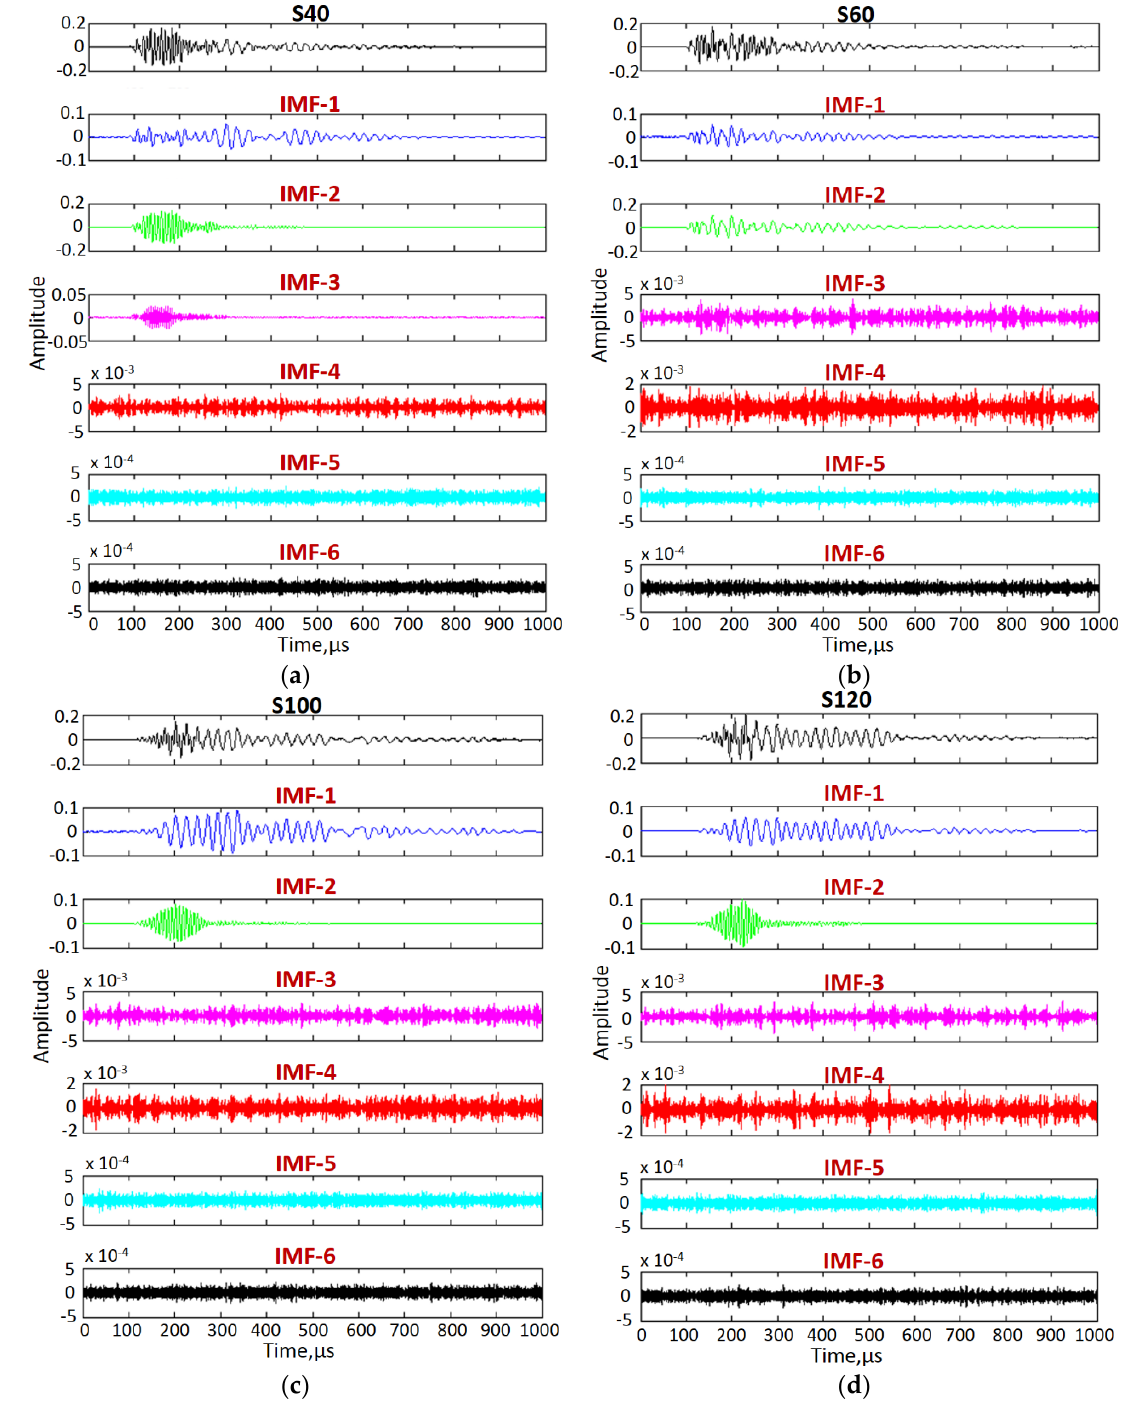
Figure 7. Signal decomposition using VMD: Decomposition of S40 ( a ) and S60 ( b ) defect-free signals and S100 ( c ) and S120 ( d ) defective signals into six intrinsic modes.